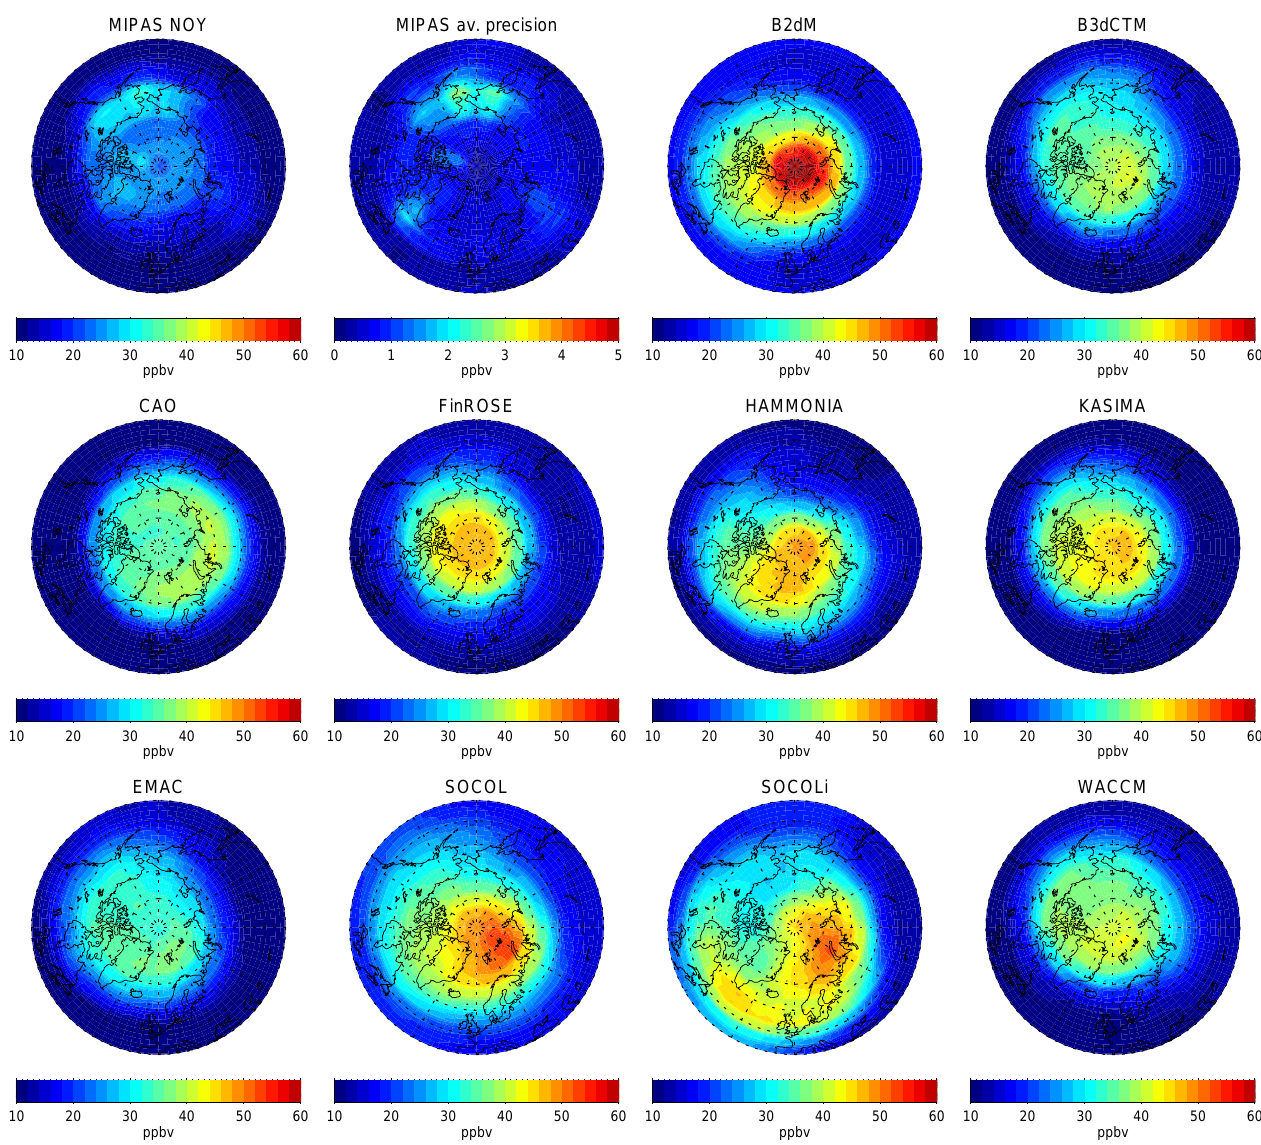
Fig. 14. Spatial distributions of observed and modeled NO y at 1hPa averaged over the period of the main proton forcing during 30 October– 1 November. The average precision of MIPAS observations is also shown (upper second panel from the left). stratosphere (1 hPa) averaged over the period 30 October– 1 November. The spatial extension of the modeled NO y en- hancements exhibits pronounced differences. In some cases,